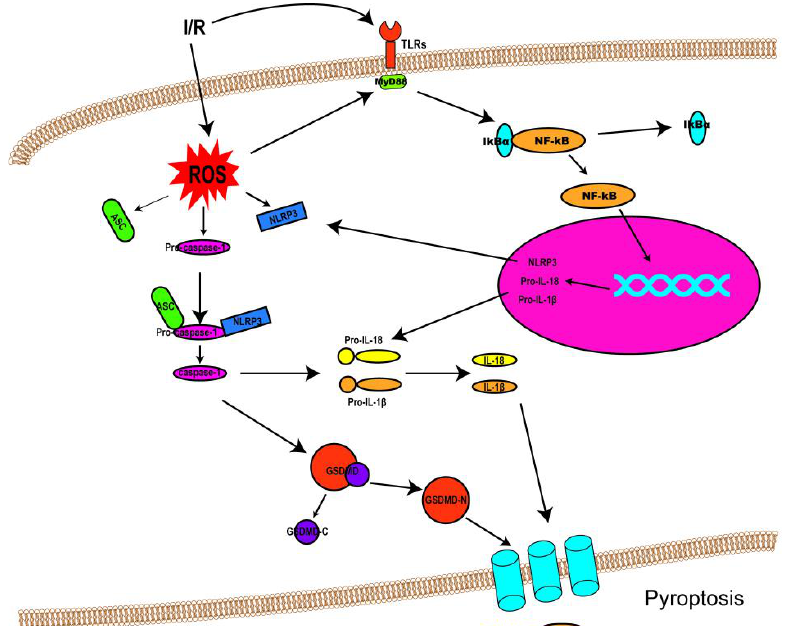
Figure 2. Schematic diagram demonstrating the link between pyroptosis and I/R injury. Following I/R insults, NF- κ B signaling (priming) is activated by Toll-like receptors (TLRs), and ROS are also produced, resulting in NLRP3 inflammasome assembly and caspase-1 activation. Activated caspase-1 cleaves GSDMD into GSDMD-N and GDSMD-C and lyses the precursors of IL-1 β and IL-18 (pro-IL β and pro-IL- 18, respectively) to form mature IL-1 β and IL-18. Then, GSDMD-N oligomerizes and penetrates the cell membrane, forming non-selective pores on the membrane to release IL-1 β and